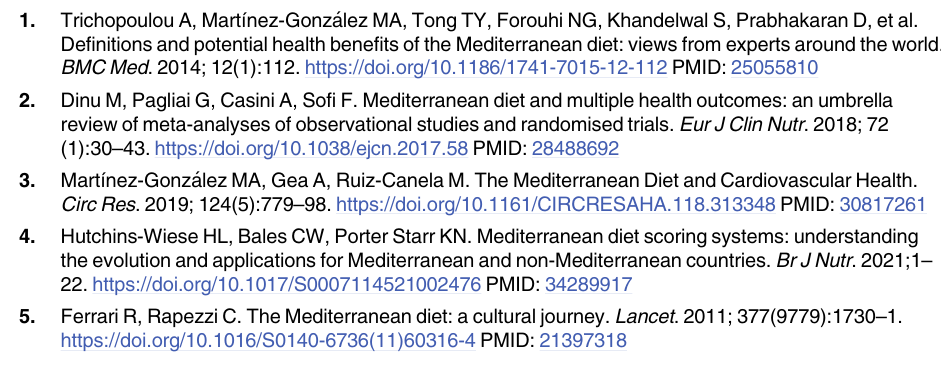
S1 Table. PRISMA-P 2015 checklist to address the systematic review protocol, adapted from Table 3 in Moher D et al: Preferred reporting items for systematic review and meta- analysis protocols (PRISMA-P) 2015 statement. Systematic Reviews 2015 4:1. S2 Table. Characteristics of studies included in the systematic review and meta-analysis. Abbreviations: CRF, cardiorespiratory fitness; MD, Mediterranean Diet; MF, motor fitness; MSF, musculoskeletal